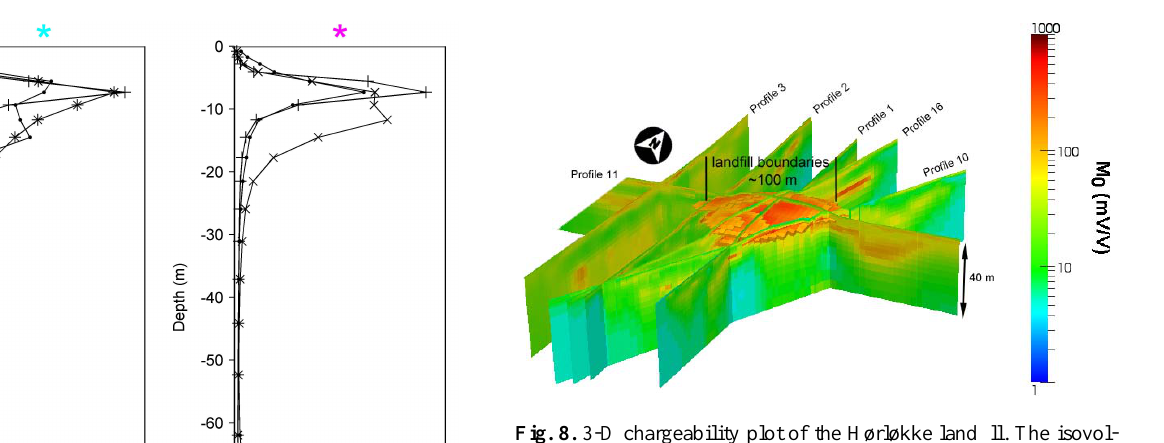
Fig. 8. 3-D chargeability plot of the Hørløkke landfill. The isovol- ume map with chargeability ( M 0 ) above 100mVV − 1 allows de- picting the landfill area without